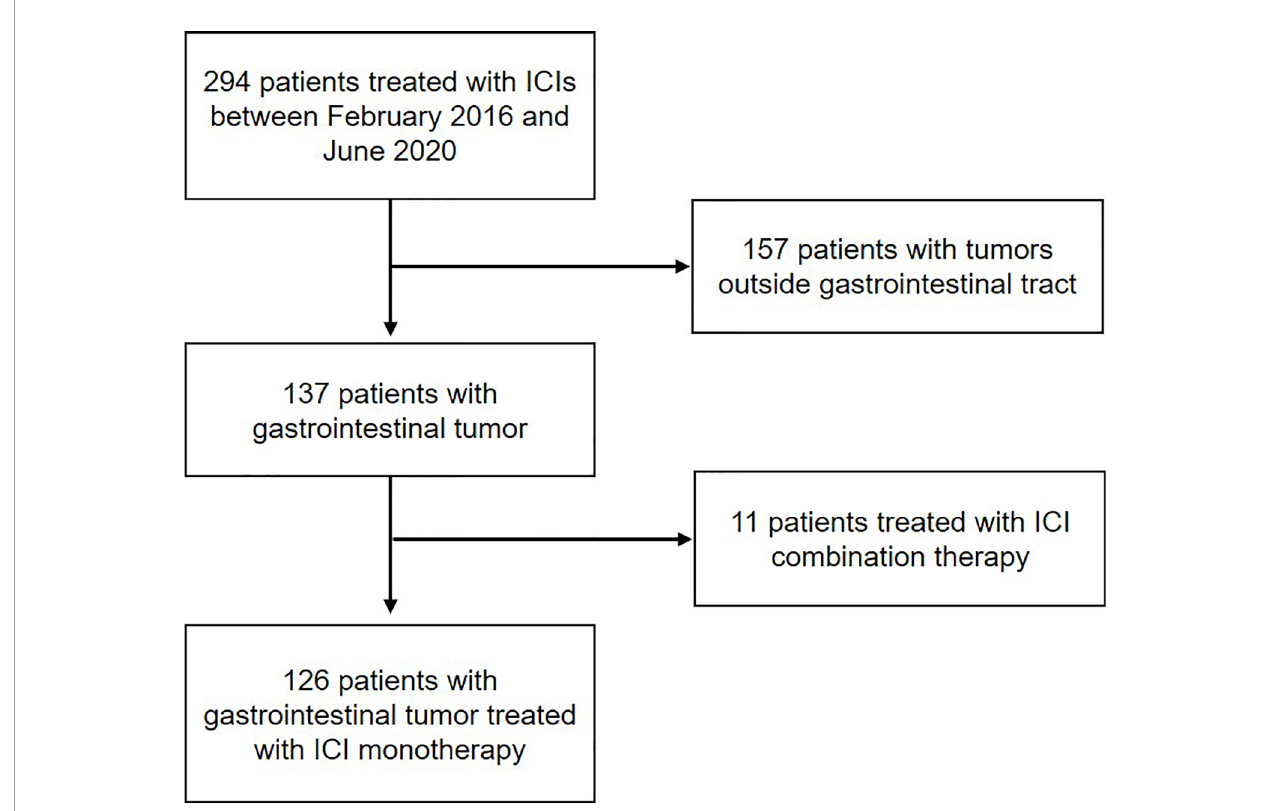
FIGURE 1 | Work fl ow of the study. Flow diagram illustrating the patients included for the analytical